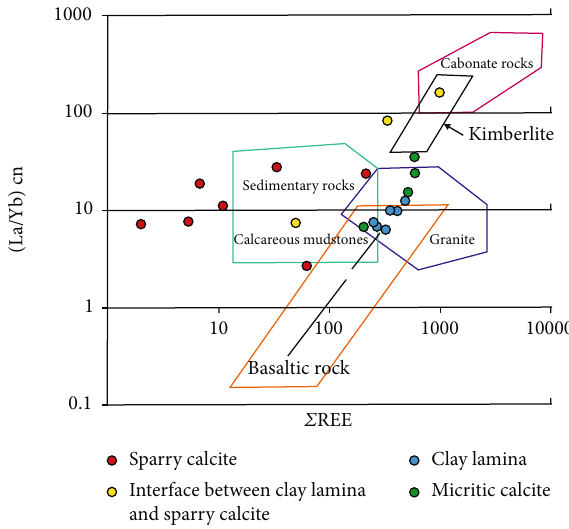
‐ Σ REE diagram of laminated argillaceous Figure 7: ð La/Yb Þ cn sparry limestone